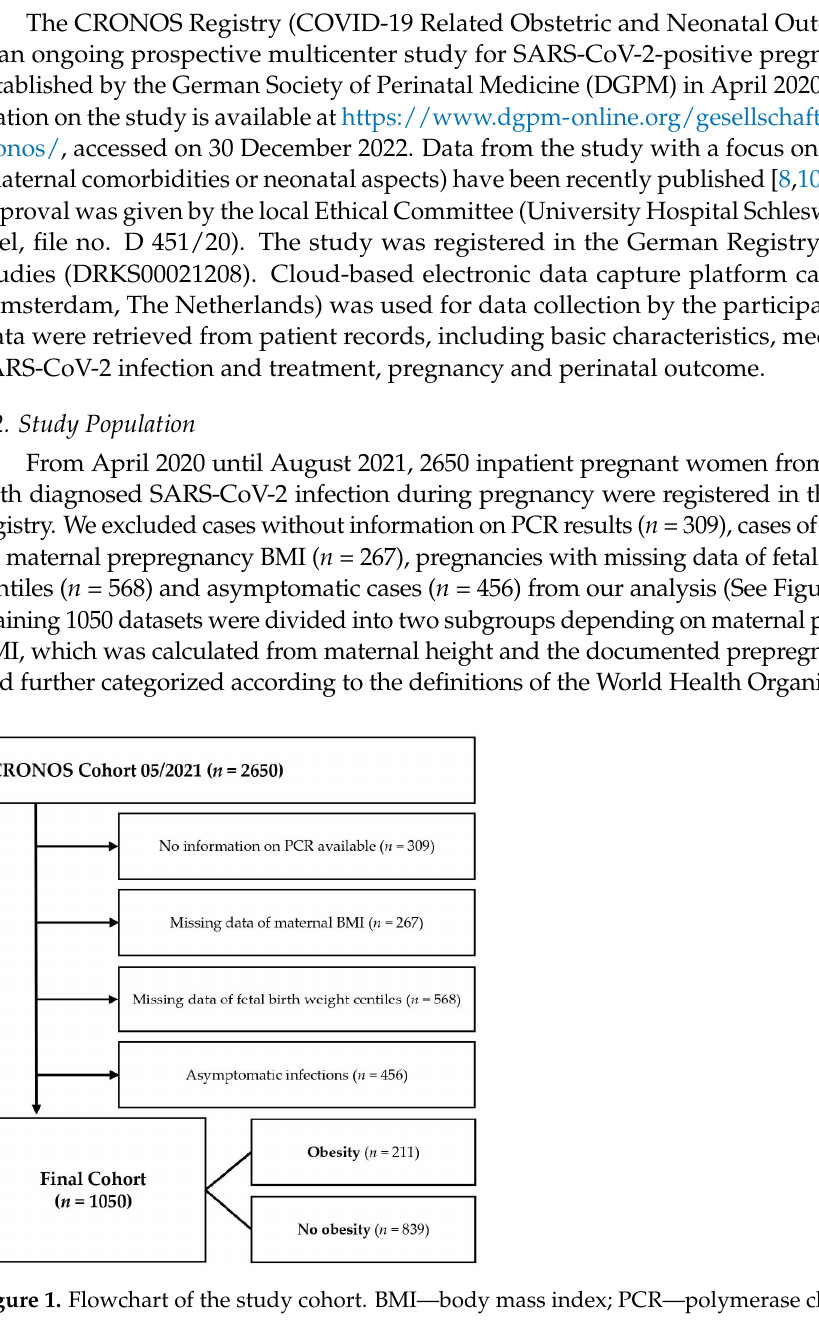
Figure 1. Flowchart of the study cohort. BMI—body mass index; PCR—polymerase chain reaction.